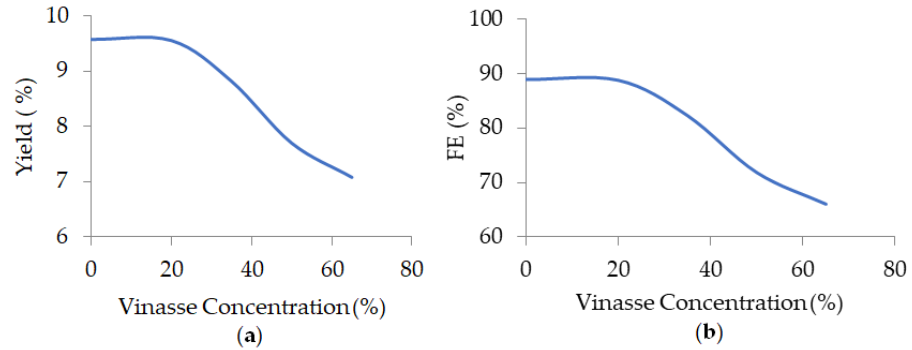
Figure 1. ( a ) Effect of vinasse concentration on yield. ( b ) Effect of vinasse concentration on FE.